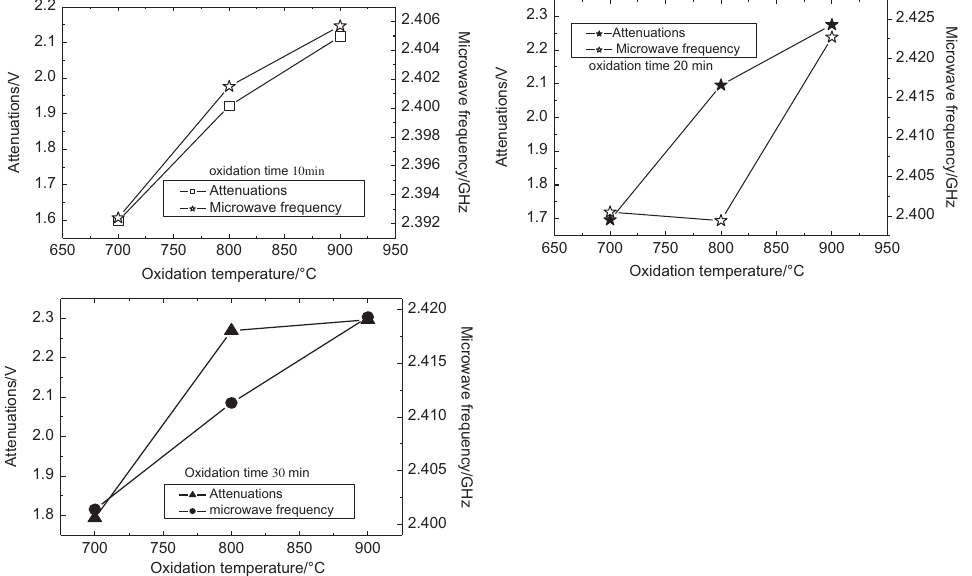
Figure 4: Effect of oxidation temperature on the attenuation and microwave frequency of oxidation products treated for 10 min (top), 20 min (middle) and 30 min (bottom) from the – 80 + 120 mesh ilmenite